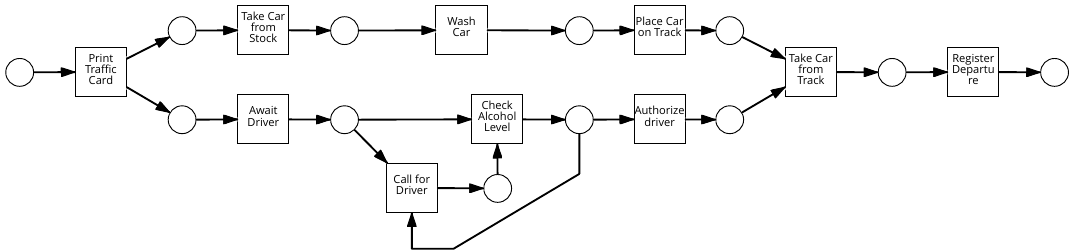
Figure 7. An example of an equivalent model to the spreadsheet-based process description presented in Table 18.